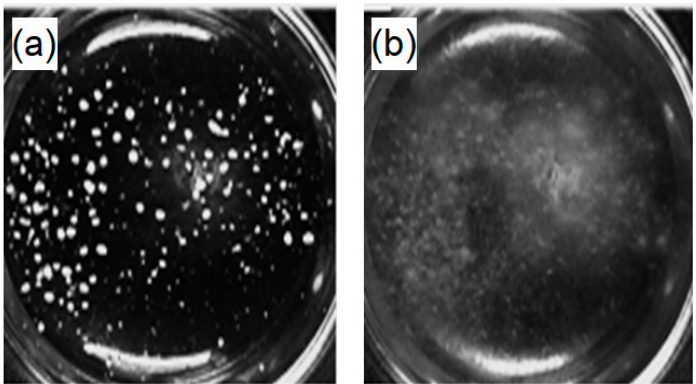
Figure 6. Pictures of a well containing the selective medium with powder of PHB/BDF blend as a sole carbon source: ( a ) medium at t 0 and ( b ) after 240 h of fungal growth.